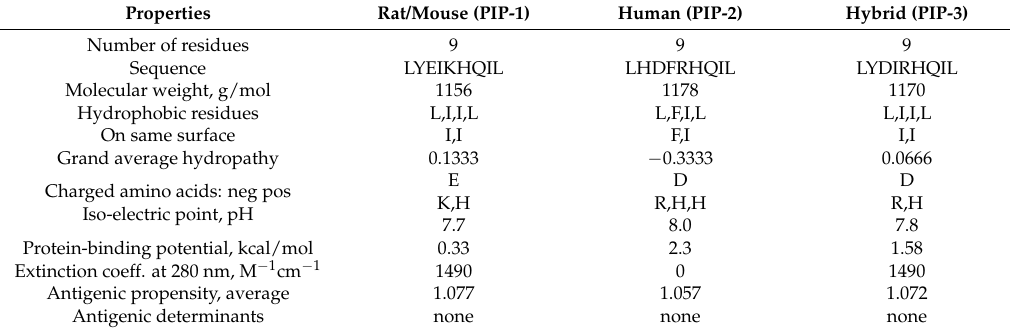
Table 4. Properties of inhibitory